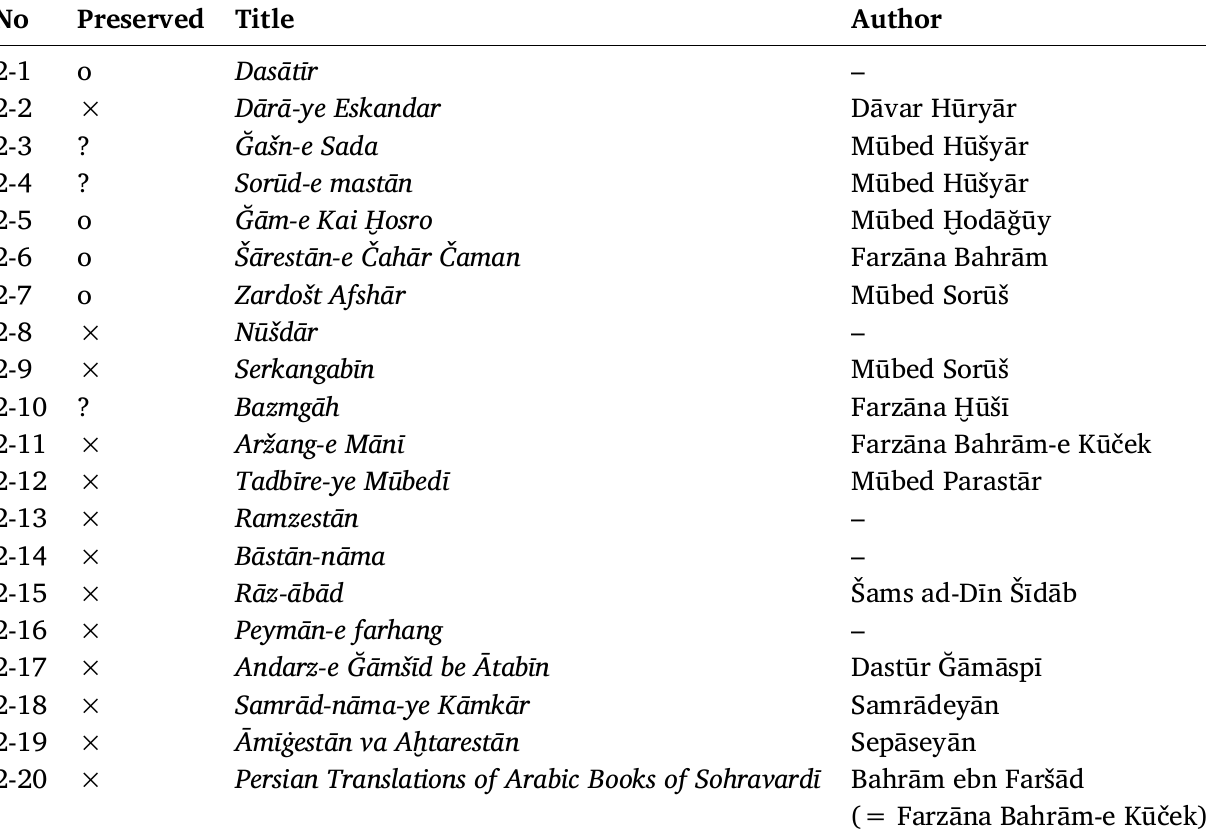
Table 3 The 20 (presumed lost) titles in Dabestān-e